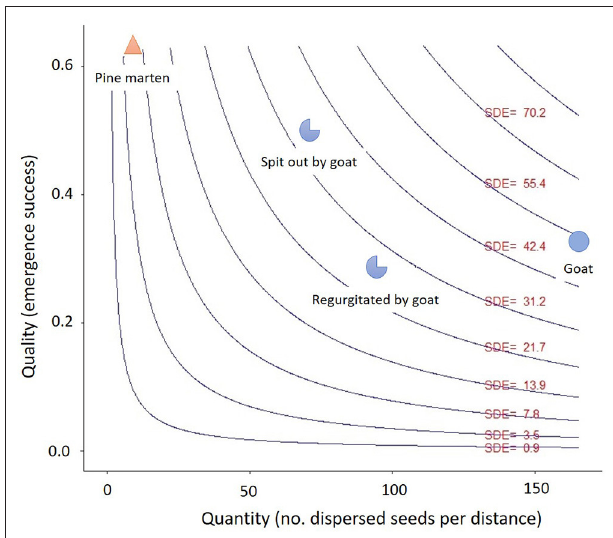
FIGURE 8 | Seed dispersal effectiveness (SDE) landscape. The blue circles indicate the quantitative and qualitative components for goat-treatments, both separated (regurgitated and spit out seeds) and together, and the orange triangle the quantitative and qualitative components for pine marten. The isoclines (blue lines) and the SDE values (red) show the seed dispersal effectiveness (quantity x quality) throughout the SDE